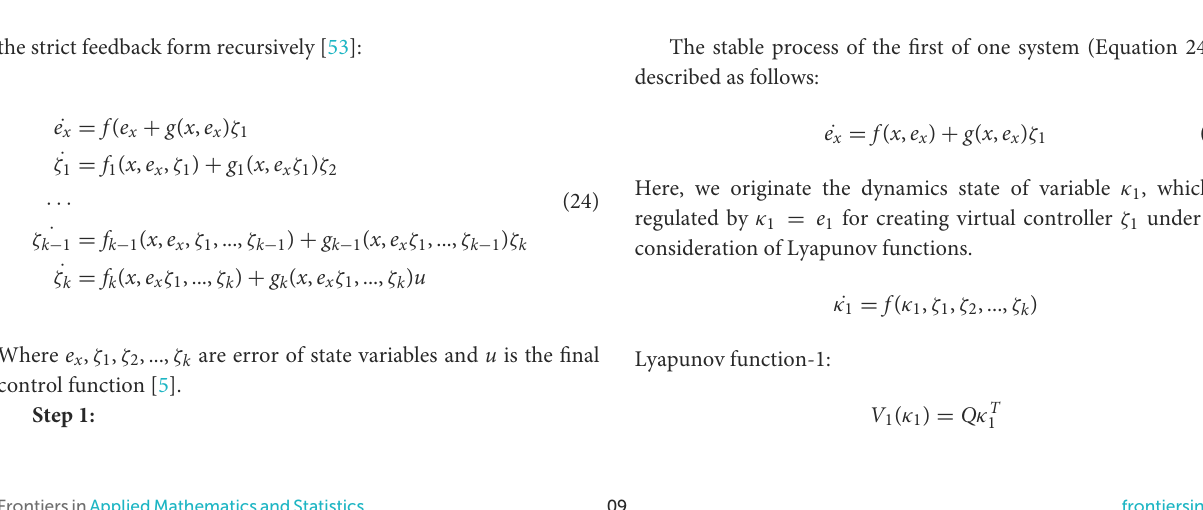
the strict feedback form recursively